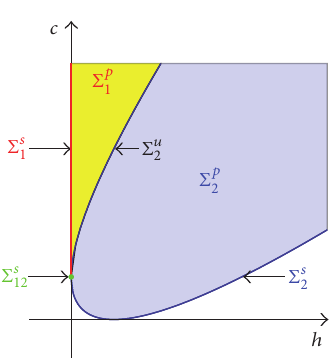
Figure 2: The image of the energy-Casimir mapping as a union of connected semialgebraic